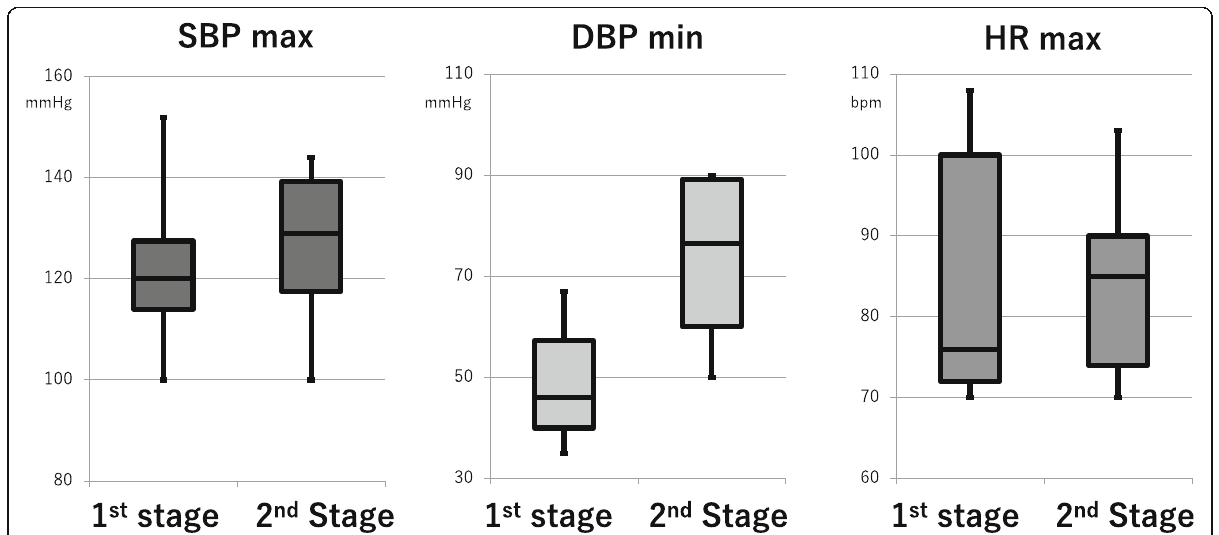
Fig. 1 Hemodynamic parameters during labor and delivery under anesthesia. Legends: SBP; systolic blood pressure, DBP: diastolic blood pressure, HR: heart